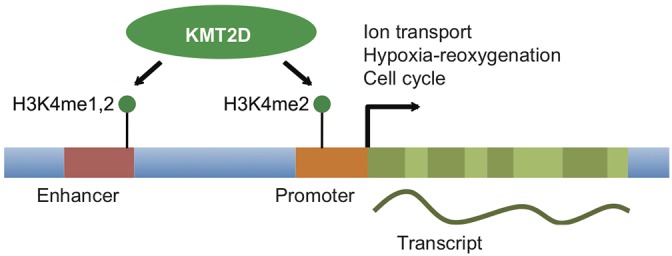
KMT2D is required for H3K4 di-methylation (and mono-methylation) to maintain specific gene expression programs in heart development. Diagrammatic representation of a protein-coding gene, including promoter and enhancer, acted upon by KMT2D to deposit the histone modifications H3K4me1 and H3K4me3.